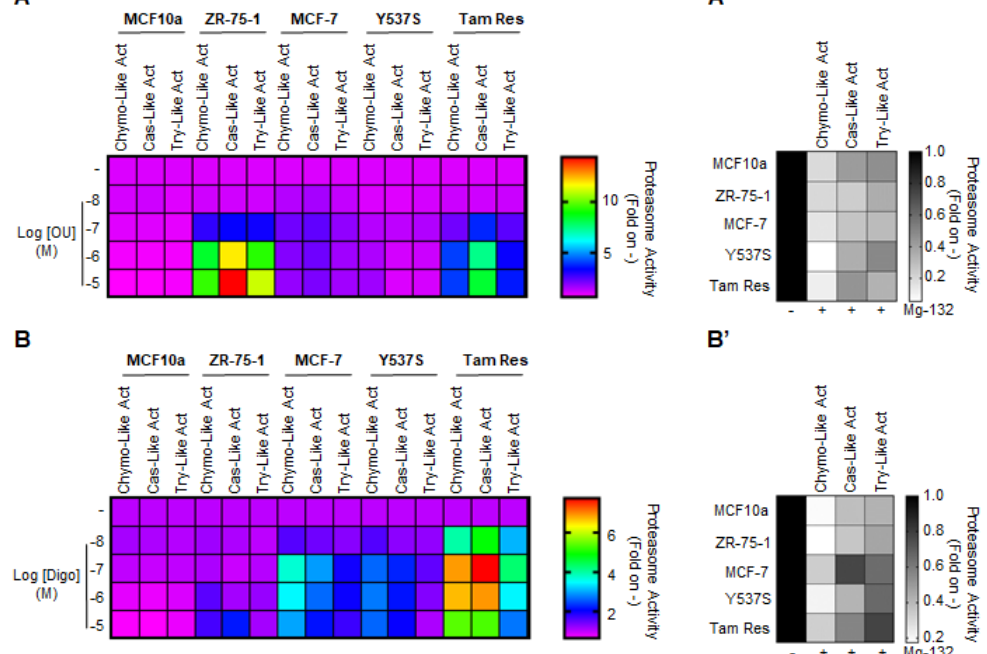
Figure 4. The effect of ouabain and digoxin on proteasome activity in cell lines. Evaluation of the proteasome activities (i.e., chymotrypsin-like, caspase-like, and trypsin-like) in the indicated cell lines, treated for 24 h with the indicated doses of ouabain (OU) ( A ) and digoxin (Digo) ( B ). ( A’ , B’ ) Effect of the proteasome inhibitor Mg-132 (1 µM) administered to the tested cells for 24 h on all three proteasome activities (i.e., chymotrypsin-like, caspase-like, and trypsin-like). All experiments were performed three times, in triplicates. Heatmaps present the mean values. The original data are provided in the source data file, and the graphs are depicted in Figure S5.